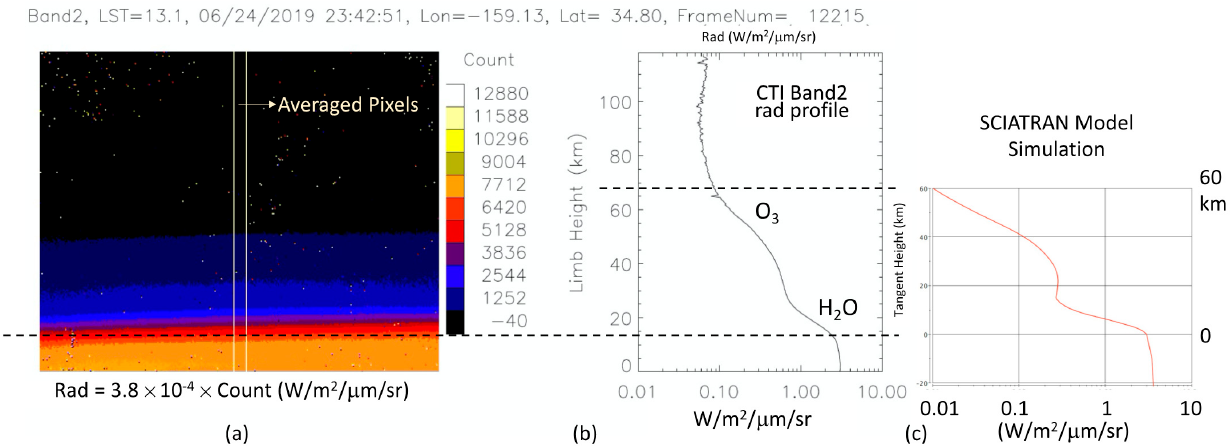
Figure 3. As in Figure 2, but for CTI band 2: ( a ) daytime (LST = 13.1 h) CTI band2 (LWIR) limb radiances from the pitch-up maneuver on 24 June 2019 (UTC = 22:54:20Z); ( b ) CTI radiance profile from the averaged pixels in ( a ); ( c ) simulated radiance profile from SCIATRAN.